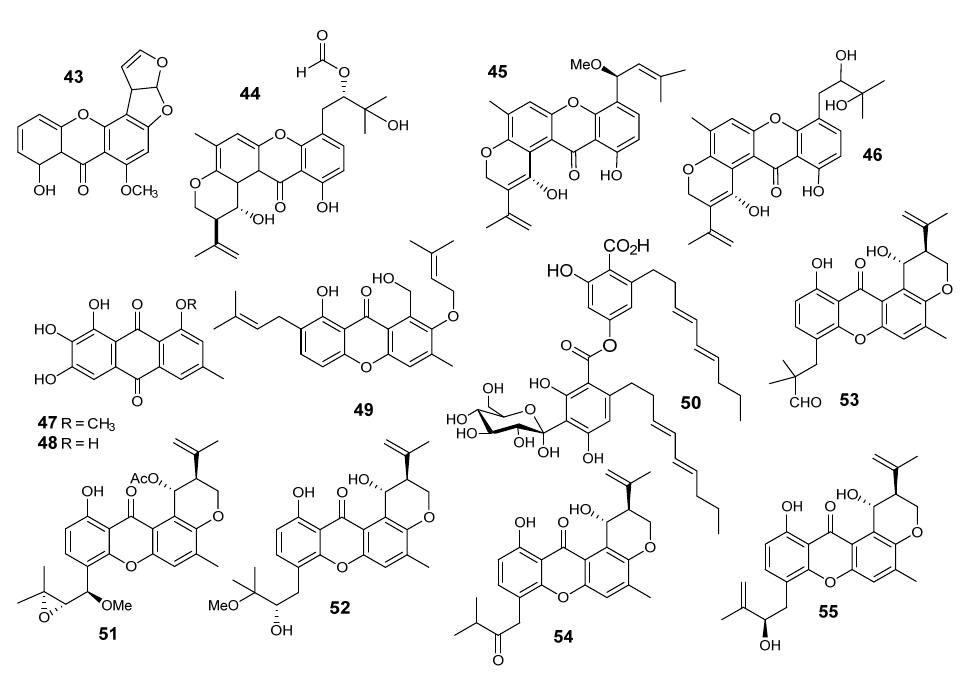
Figure 3. Structures of compounds 43–55.